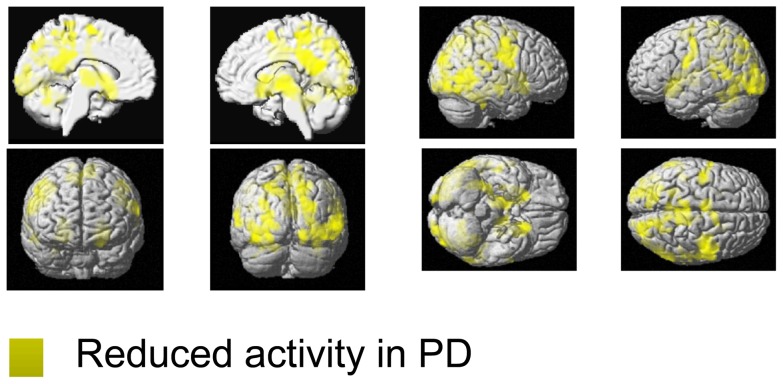
Functional working-memory related correlates in PD and controls during the encoding phase.Regions showing significantly lower activity (yellow) in PD relative to healthy controls during the encoding phase of the motor WM task. All significant effects are displayed on the MNI single subject template and the color bar represents T-values.